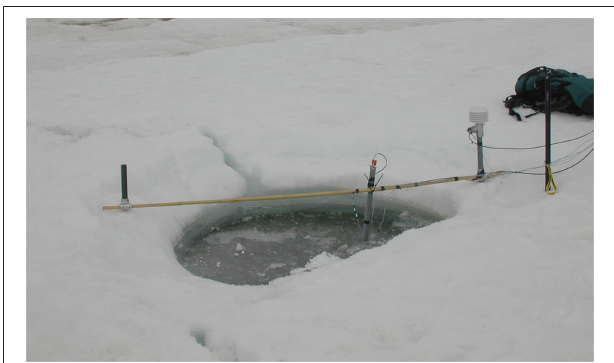
FIGURE 2 | Cryoconite hole in Canada Glacier draining into a supraglacial stream. The diameter of the cryoconite hole is 1.5m.